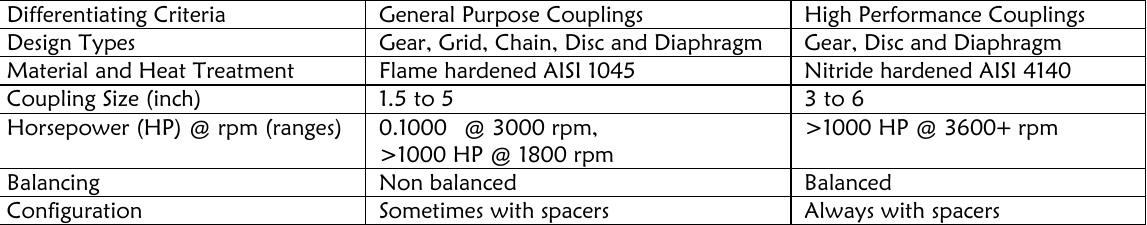
Table 1: Distinguishing traits of general and high performance couplings